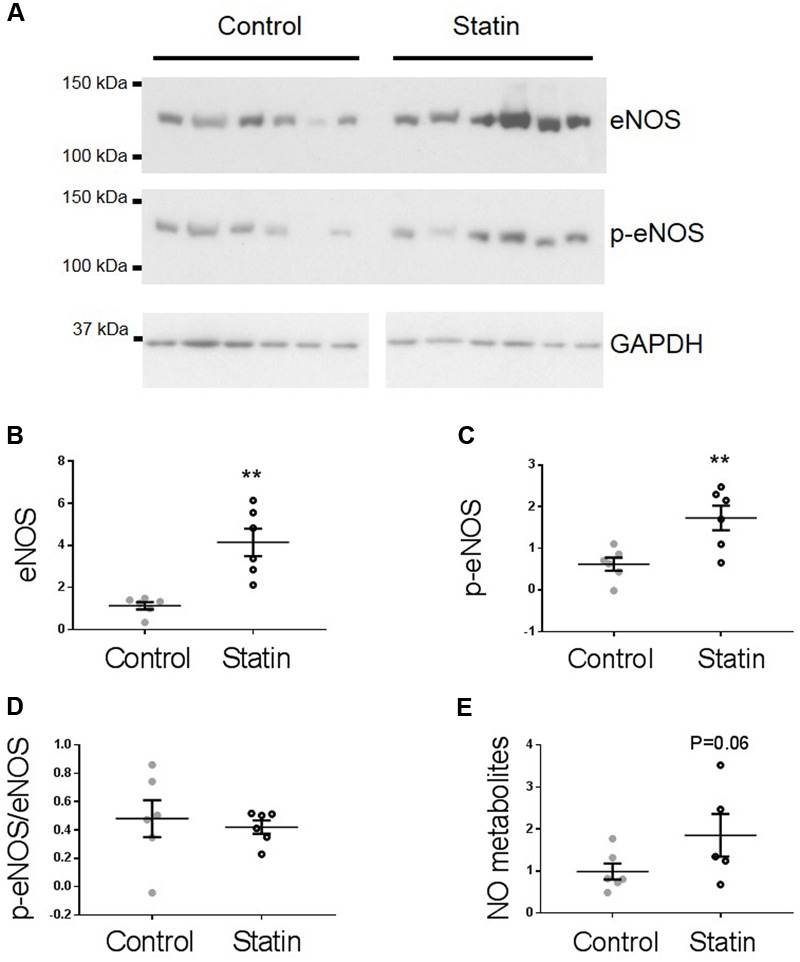
Simvastatin increases eNOS expression and phosphorylation. Representative immunoblots (A) and scatter plots showing myocardial levels of eNOS (B) and Ser1177 phosphorylated eNOS (p-eNOS, C) normalized to GAPDH. (D) The proportion of total eNOS phosphorylated at Ser1177 was not different between groups. (E) NO metabolites (nitrate + nitrite) measured by a fluorimetric assay. Plots show mean ± SEM from N = 6 animals per group. ∗∗P < 0.01 vs. control group, Student’s t-test.